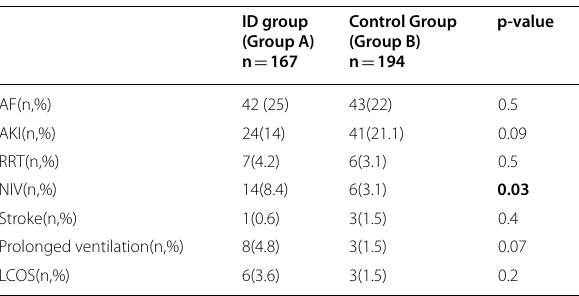
Table 1 Comparison of Group A (iron deficiency group) to Group B (con- trol) shows a statistically significant variation in the use of NIV for iron deficient patients